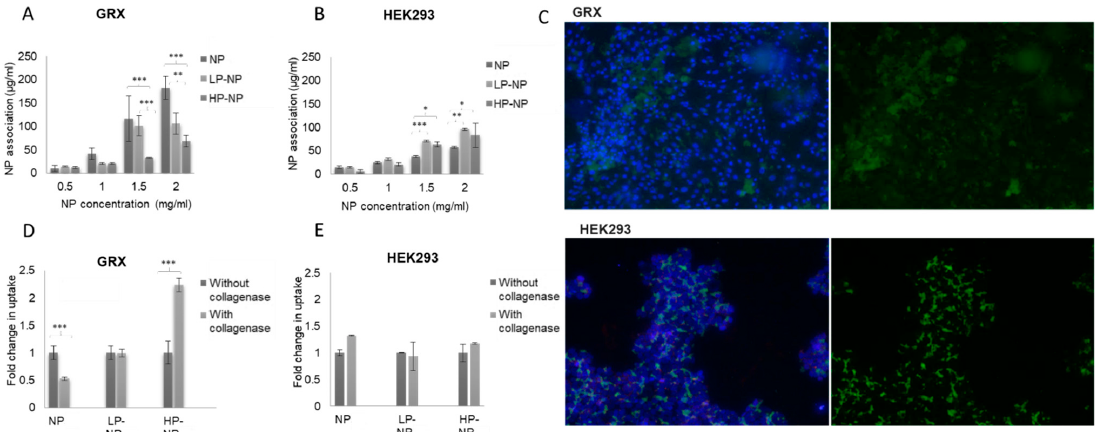
Figure 3. CS-NP association in GRX and in HEK293 cells as a function of NP peptide density and extracellular matrix (ECM )collagen density. CS-NP association in ( A ) GRX and ( B ) HEK293 cells results expressed as the mean ± SD concentration of NPs associated by the cells (n = 3). ( C ) Fluorescent microscopy studies of model oligo (MO)-loaded CS-NPs; when incubated for 24 h with GRX and HEK 293 cells, nuclei appear blue due to DAPI staining, whereas CS-NPs appear green . CS-NP association following pretreatment with collagenase in ( D ) GRX and ( E ) HEK293 cells; the results are expressed as the mean ± SD fold change in association as result of collagenase pre-treatment (n = 3). Statistical analysis was performed by GraphPad InStat software using a one-way analysis of variance test (ANOVA), where (*) p < 0.05, (**) p < 0.01 and (***) p < 0.001.